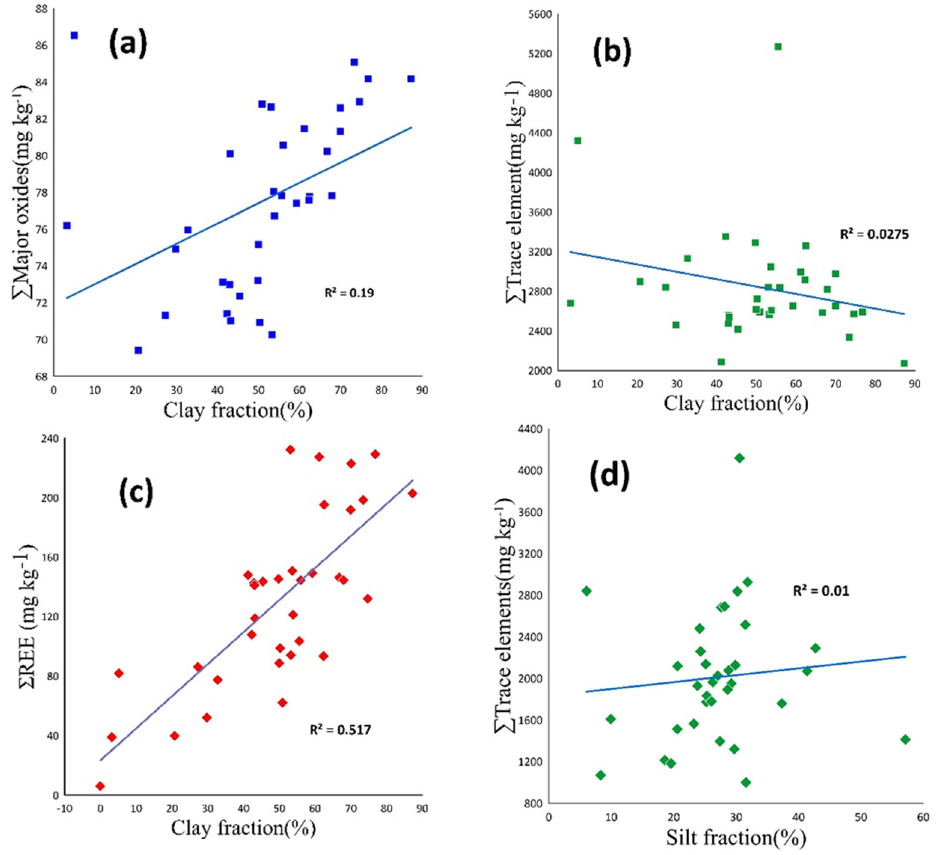
Figure 3. Correlation coefficients according to Pearson between different element groups, the main oxides ( a ), the trace elements ( b , d ), the rare earths ( c ) and the clay or silt content in soil. Due to the minerals present in the finest fraction, including accessory primary and secondary minerals, some immobile elements such as Al, Ti, Zr, Th, and REEs are typically concentrated in fine-grained sediments, as suggested by Soureiyatou et al. [43].